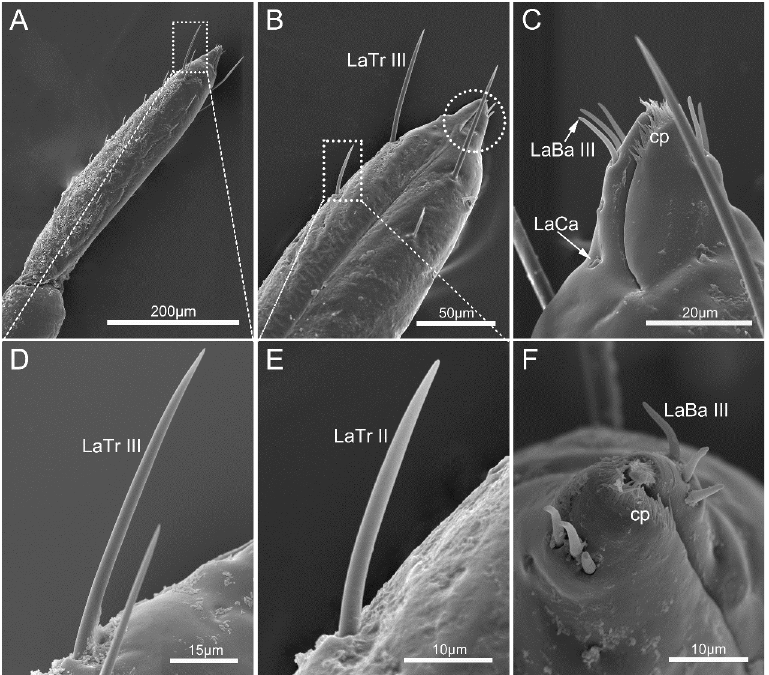
Figure 6. The fourth labial segment of Mezira yunnana . ( A ) General view of the fourth labial segment; ( B ) enlarged view showing labial sensilla trichodea III and labial sensilla II, with significantly nar- rowed labial tip shown in the circle; ( C ) enlarged view showing cuticular processes (cp), labial sen- silla basiconica III (LaBa III), and labial sensilla campaniformia (LaCa); ( D ) labial sensilla trichodea III (LaTr III); ( E ) labial sensilla trichodea II (LaTr II); ( F ) vertical view of labial tip. The labial tip is cleft and distinctly divided into two asymmetrical lateral lobes, and the left lobe is slightly wrapped around the right on the ventral surface (Figure 6C,F). Three pairs of labial sensilla basiconica III (LaBa III) encircle the labial tip, which is slightly curved (Figure 6C,F). Several labial sensilla campaniformia (LaCa) are located on the sur- face near the LaBa III, each of which is leaf-shaped (Figure 6C). Small comb-shaped cutic- ular processes (cp) densely encircle the opening (Figure 6C,F).